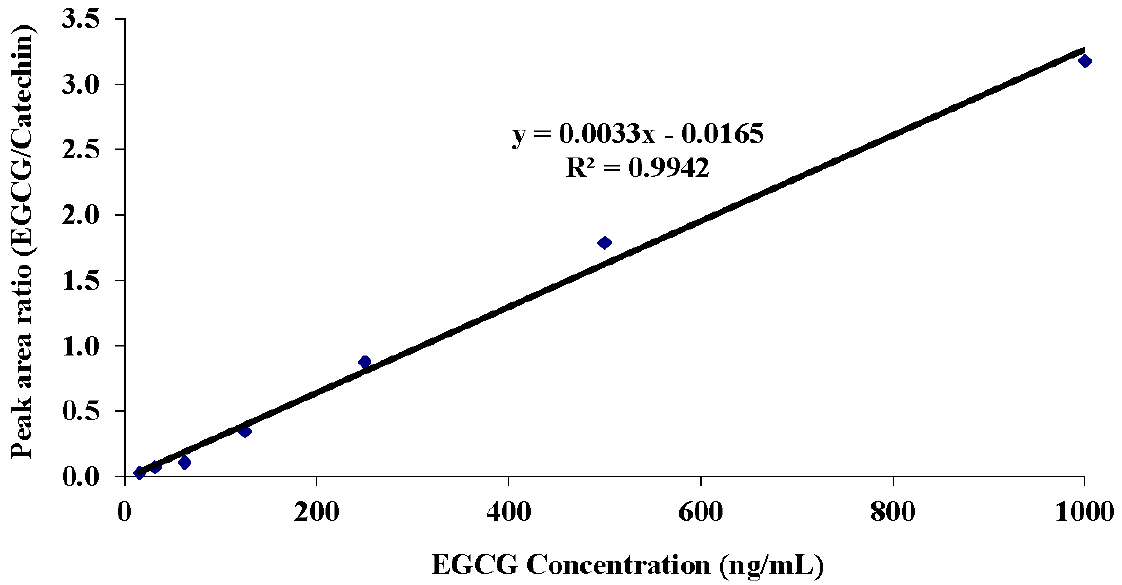
Figure 3. Calibration curve for EGCG spiked into human plasma at increasing concentrations and detected using the optimised HPLC ESI-MS system.